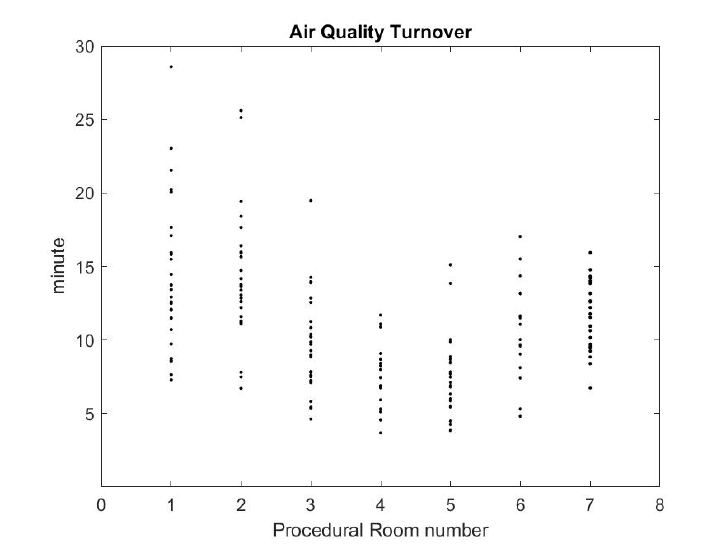
Figure 12. Turnover time computed from the HVAC formula [36].